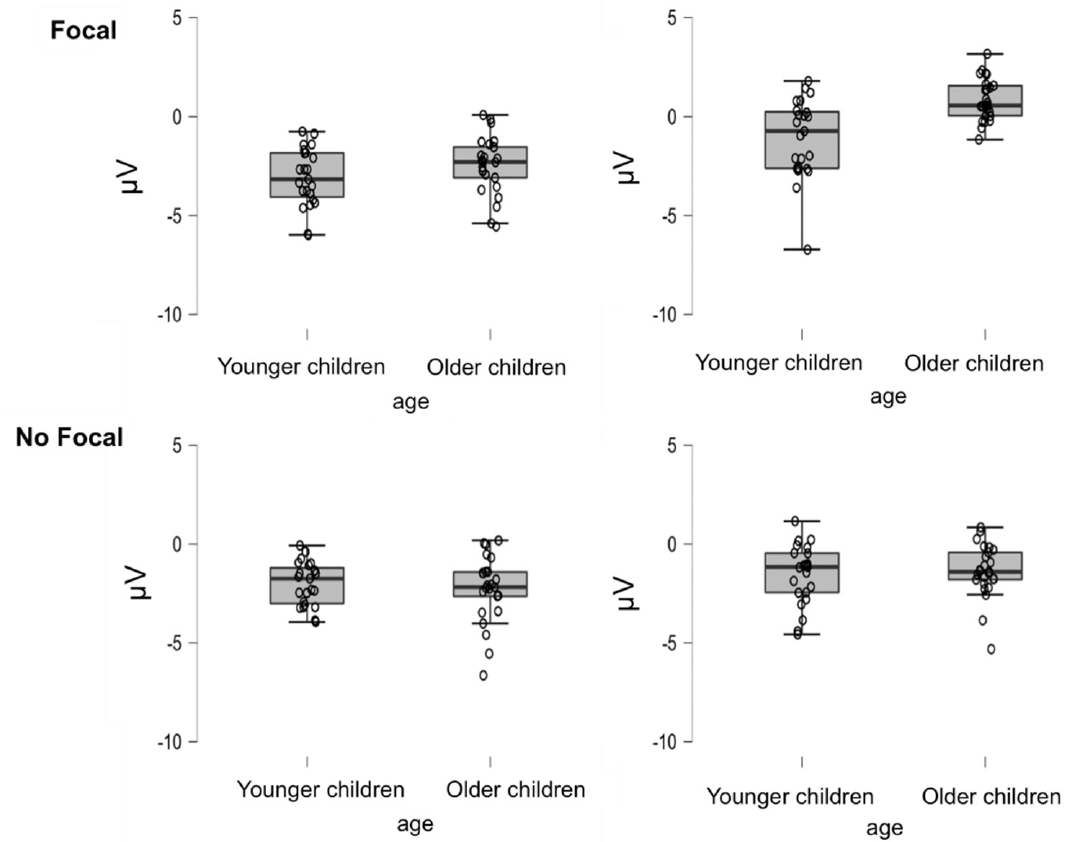
Figure 8. Box plots of the amplitude of the frontal slow waves (FSW) component as a function of age, focality and type of trial .